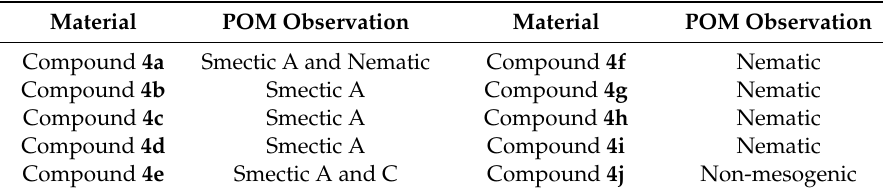
Table 3. POM observation of compounds 4a – j